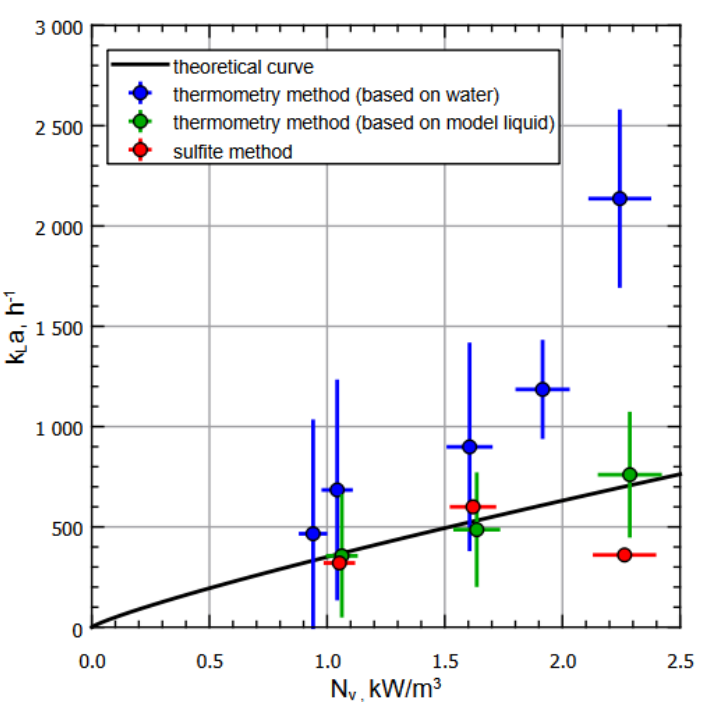
Figure 4. Dependence of k L a on N v for various liquids and methods of measuring k L a on an experimental apparatus. The measurements were carried out in the steady state mode of heat exchange between the reactor and the environment according to the measurement